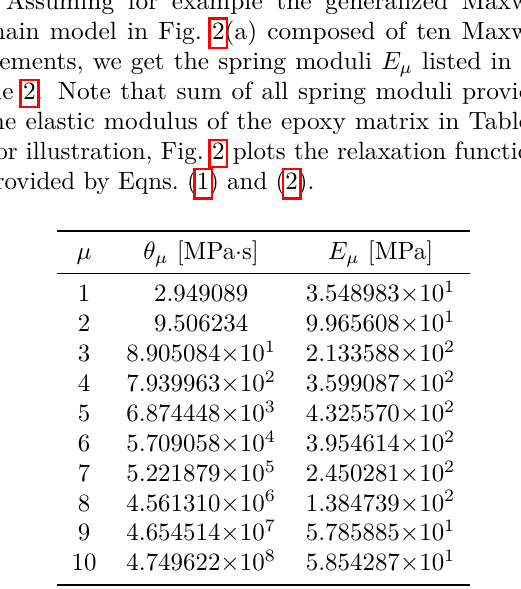
Table 2. Parameters of Maxwell chain